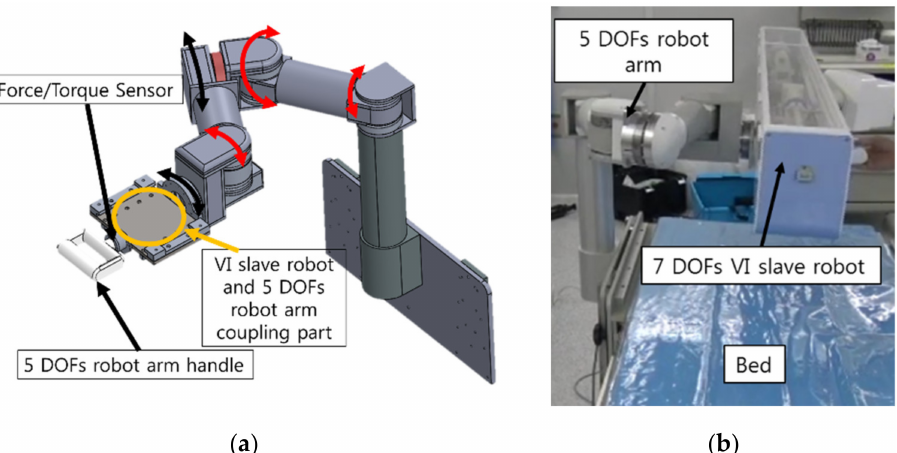
Figure 2. Schematic of the slave robot: ( a ) 5 DOFs robot arm for positioning the slave robot; ( b ) 7 DOFs VI slave robot mounted on the bed.